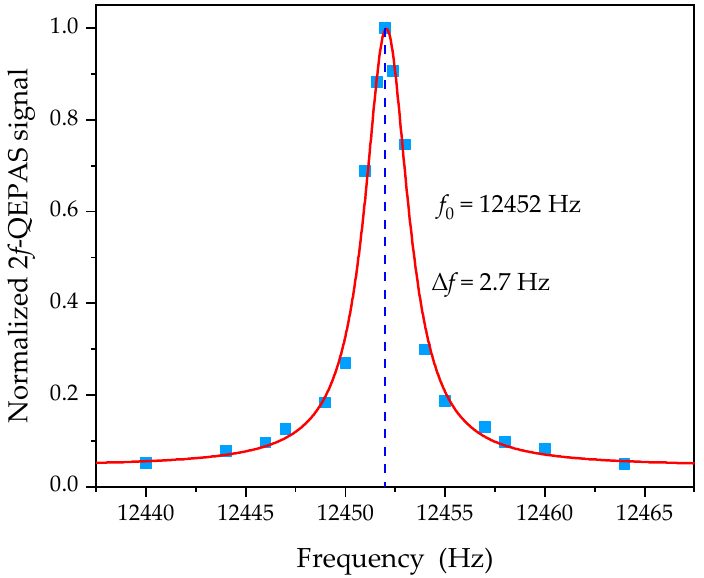
Figure A2. Frequency response characteristics of the custom QTF at 1 bar and 296 ± 2 K. The investigation was performed with 5000-ppm CO 2 /N 2 mixture filled into the ADM.